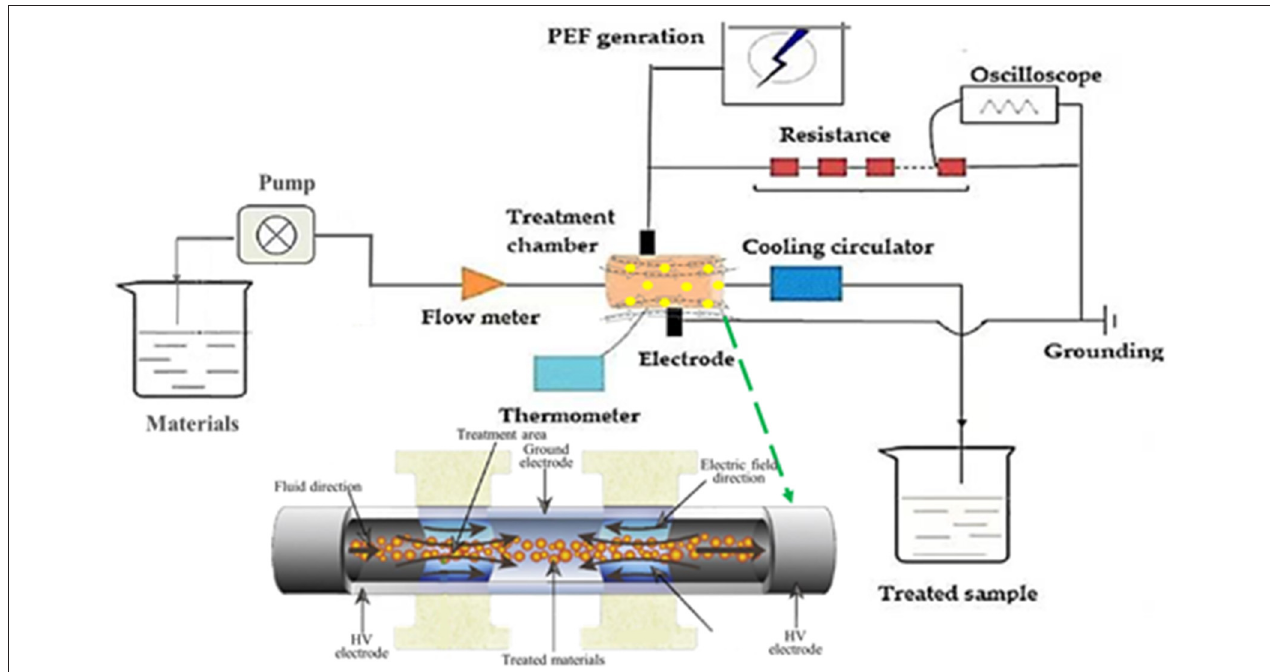
FIGURE 1 | Schematic diagram of PEF